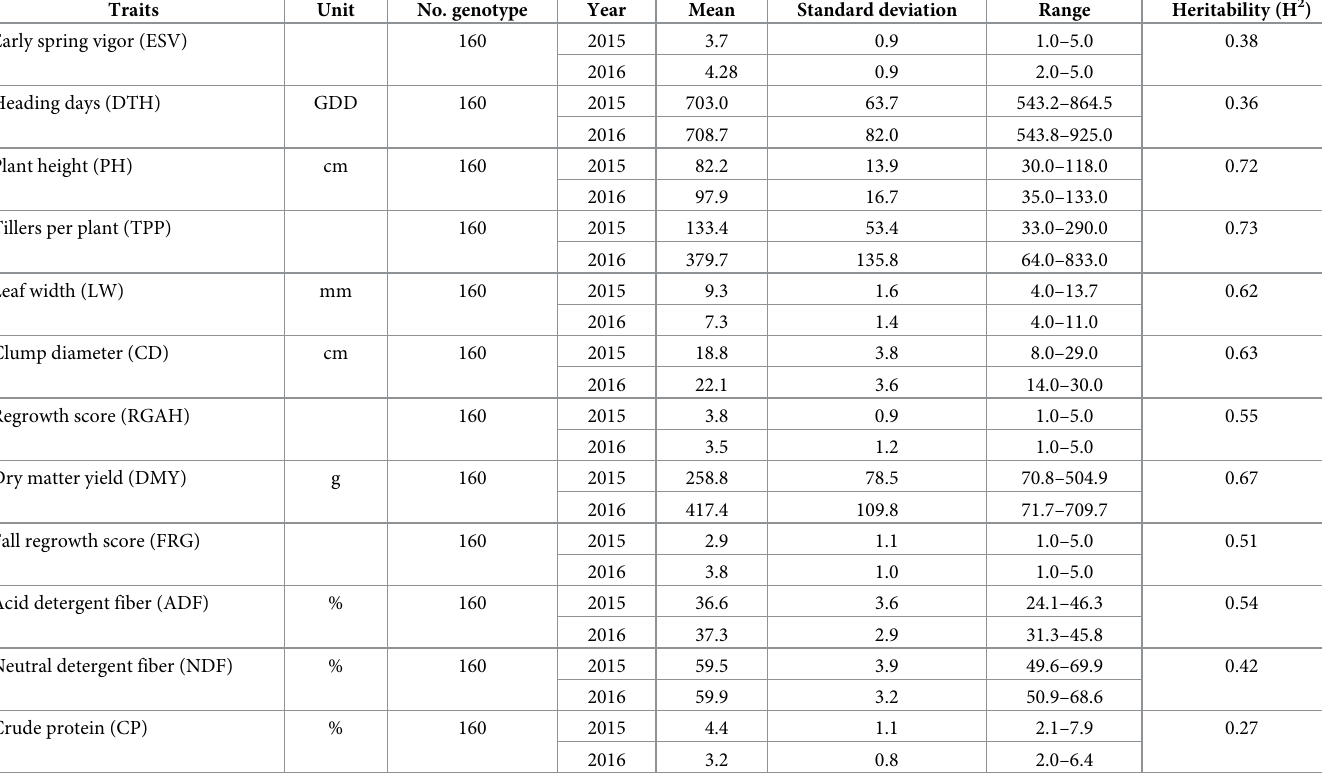
Table 3. Statistics for the distributions of nine agro-morphological and three nutritive value traits, and estimated broad-sense heritability on genotype-mean basis for crested wheatgrass evaluated in two summers at Saskatoon, Canada.